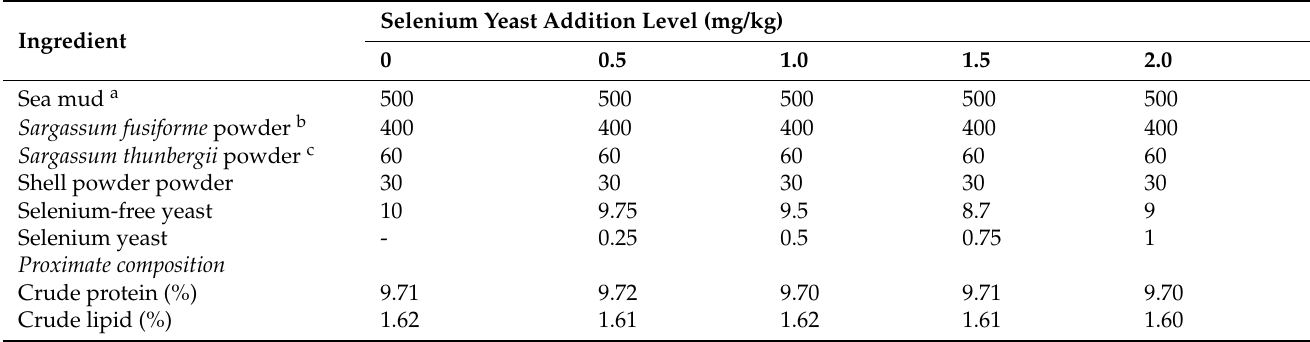
Table 1. The ingredients and proximate analysis of experimental diets